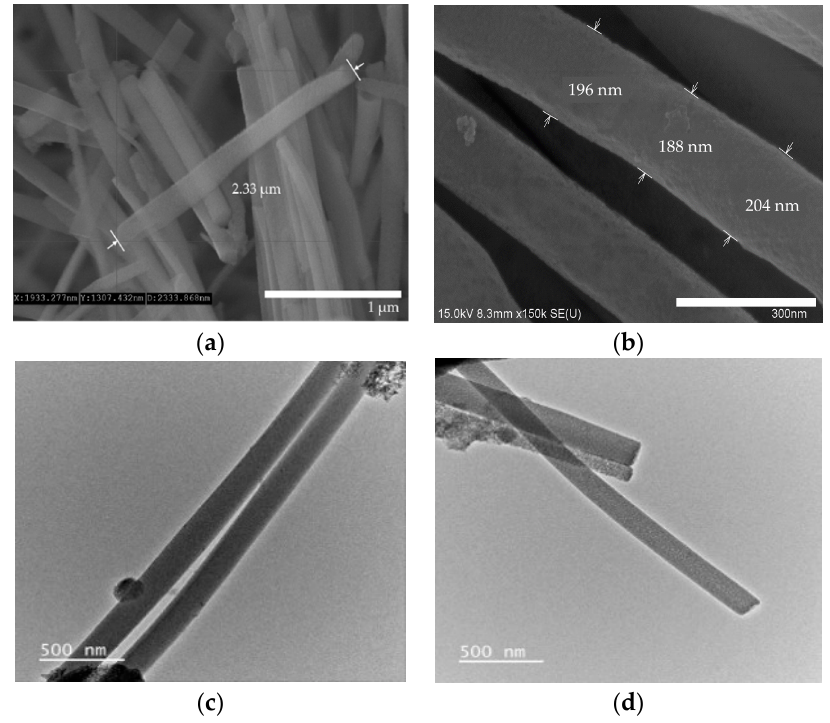
Figure 3. Scanning electron microscopy (SEM) images ( a , b ) and transmission electron microscopy (TEM) images ( c , d ) of SMWs.